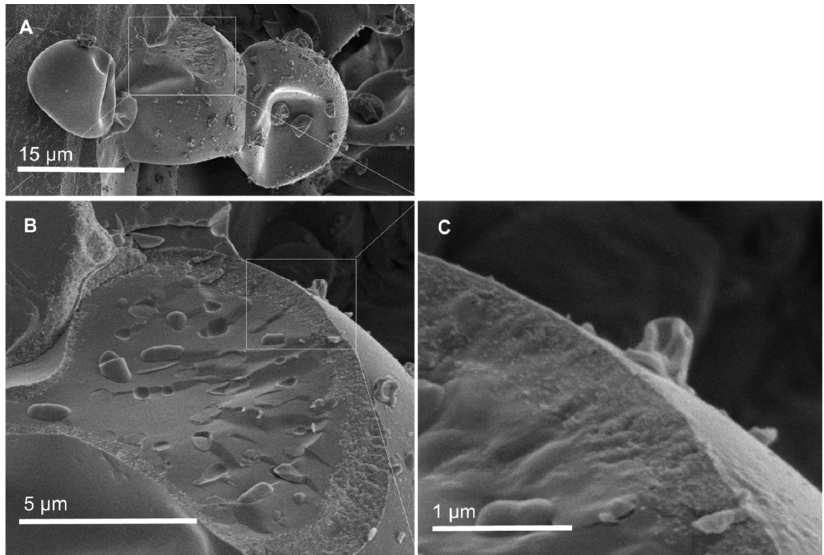
Figure 3. SEM images showing the overall structure of electrosprayed ETC core–shell microcapsules loading Bifido: ( A ) the microcapsule cross-section with ( B ) the distinct core and shell materials, and the Bifido cells distributed within the core of the microcapsules; ( C ) the interface between ETC (shell) and glycerol